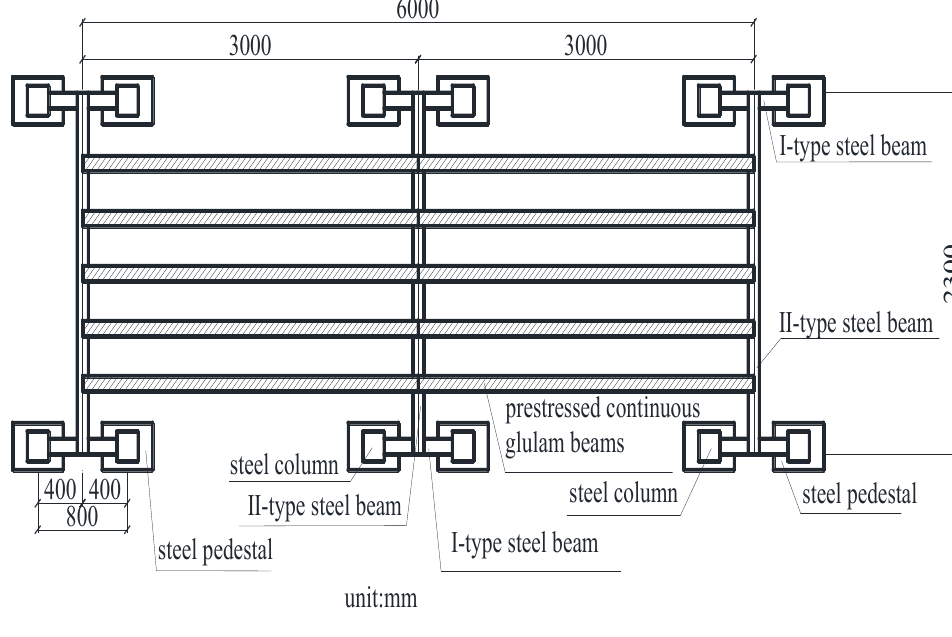
Figure 2. The plane layout of the test device.